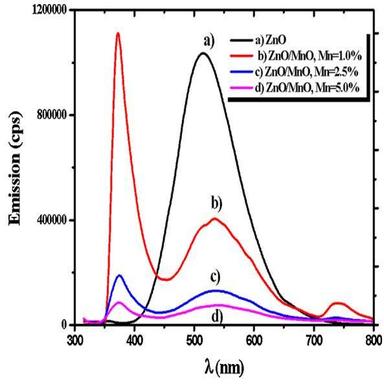
Emission spectra of ZnO/MnO nanocomposite a) 0% Mn, b) 1% Mn, c) 2.5% Mn and d) 5.0% Mn. The spectra were recorded in a range from 300 nm to 800 nm, with an excitation wavelength of 365 nm.